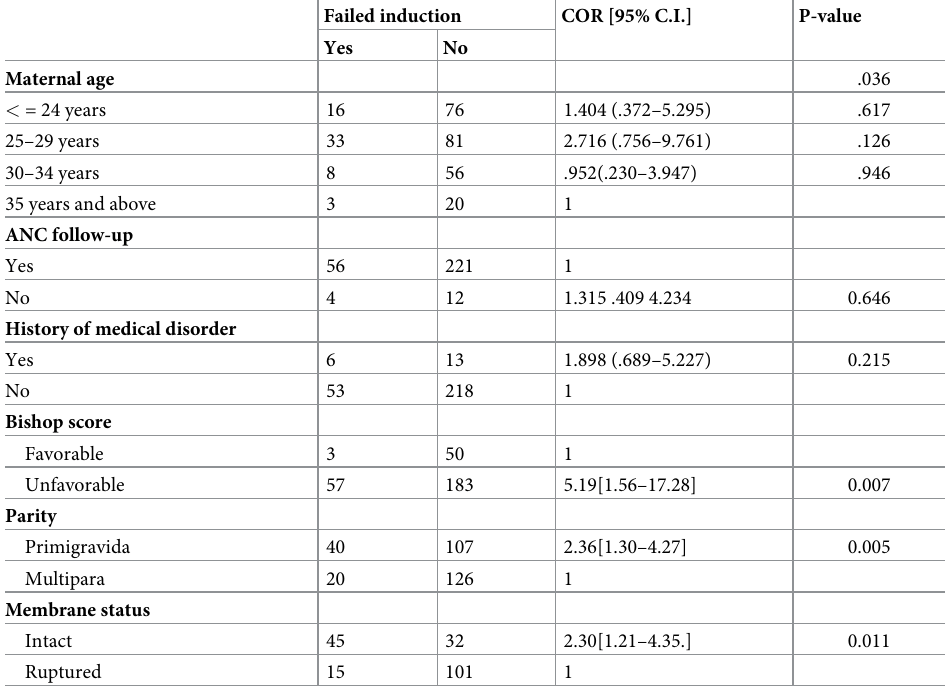
Table 4. Bivariate logistic regression analysis showing factors associated with failed induction in Adama Hospital Medical College, East Shoa, Oromia, Ethiopia, 2020, (n = 293). Failed induction COR [95% C.I.]